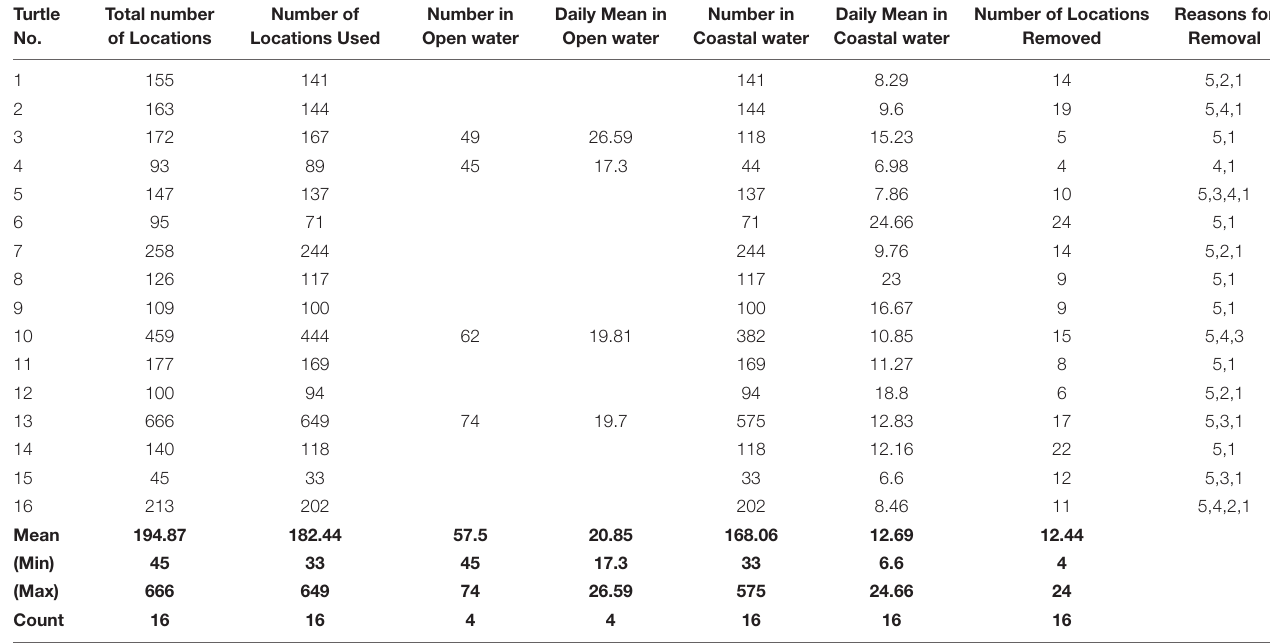
Turtle numbers are shown on Figure 1 . Codes for Reasons for Removal: 1. Accuracy of location = B, 2. Data points greater than 100 km from the previous location, 3. Speed between points was greater than 5 km/h, 4. Greater than 2 m above sea level, and 5. Over